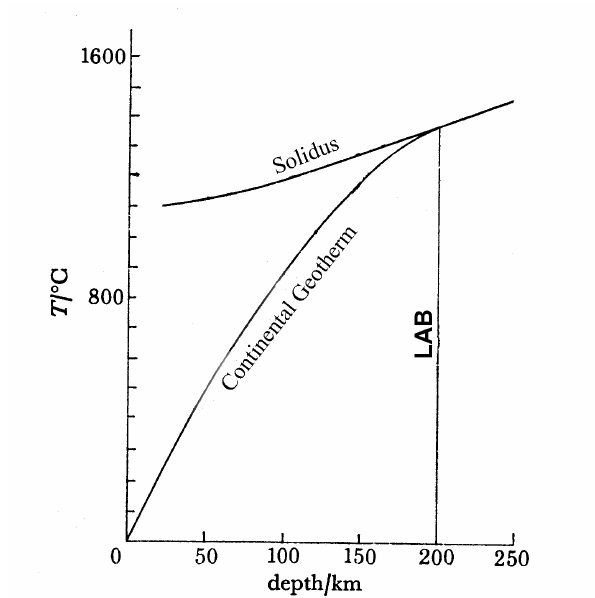
Fig. 2. Distribution of mantle solidus with depth (Modified from Gass et al., 1978). Lithosphere-asthenosphere boundary (LAB) has been defined as the intersection point of the mantle solidus and the estimated continental